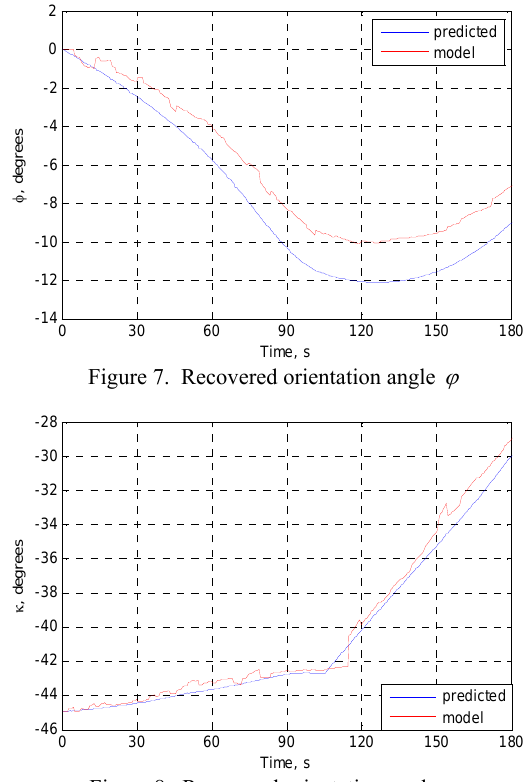
Figure 8. Recovered orientation angle κ